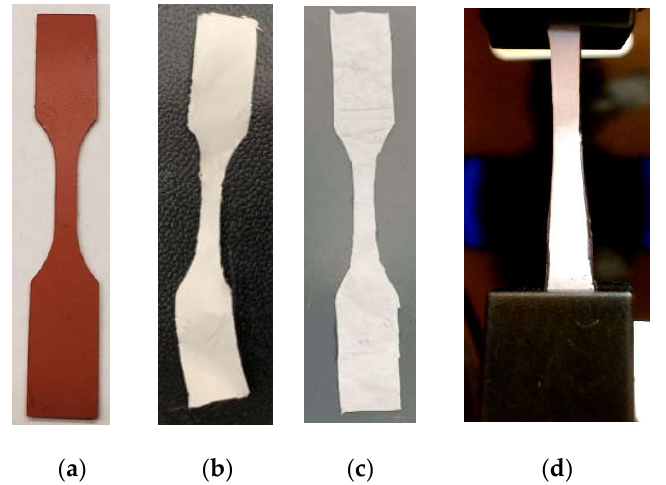
Figure 3. ( a ) ASTM D638 standard plastic specimen mold used to make tension test specimen.